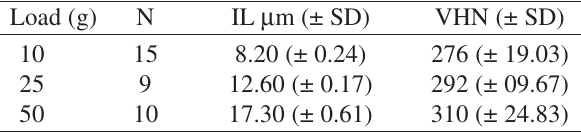
Table 1. Vicker’s hardness number (VHN) and indentation length (IL) for different loads in the same tooth zone. Mean values and standard deviations (SD) for IL and VHN are shown. N is the number of indentations, taken from the 7 samples, and taken in account for statistics. Note the increment of SD for 10 g, because the error in IL measurement is bigger, and 50 g, because excessive load.